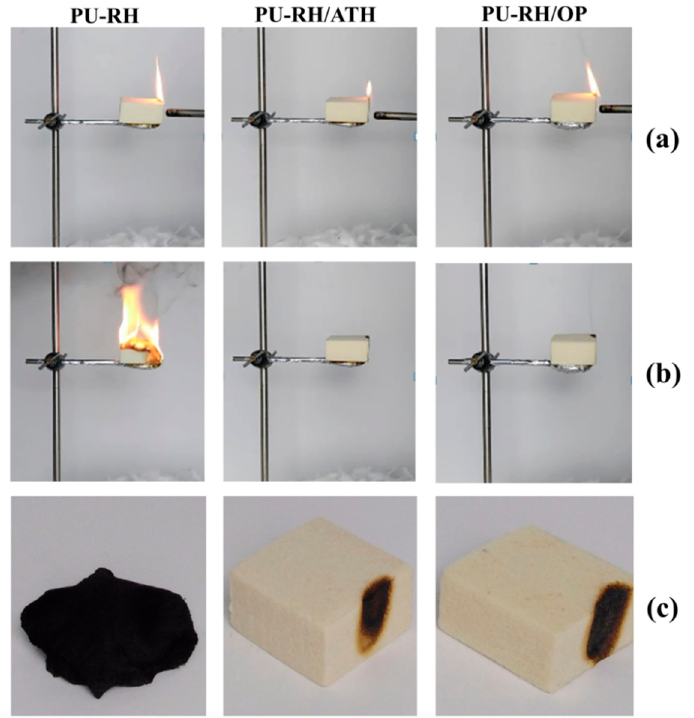
Figure 2. Photographs of the PU–RH and PU–RH / FR mixtures at ( a ) 5 s, ( b ) 10 s, and ( c ) after the combustion.